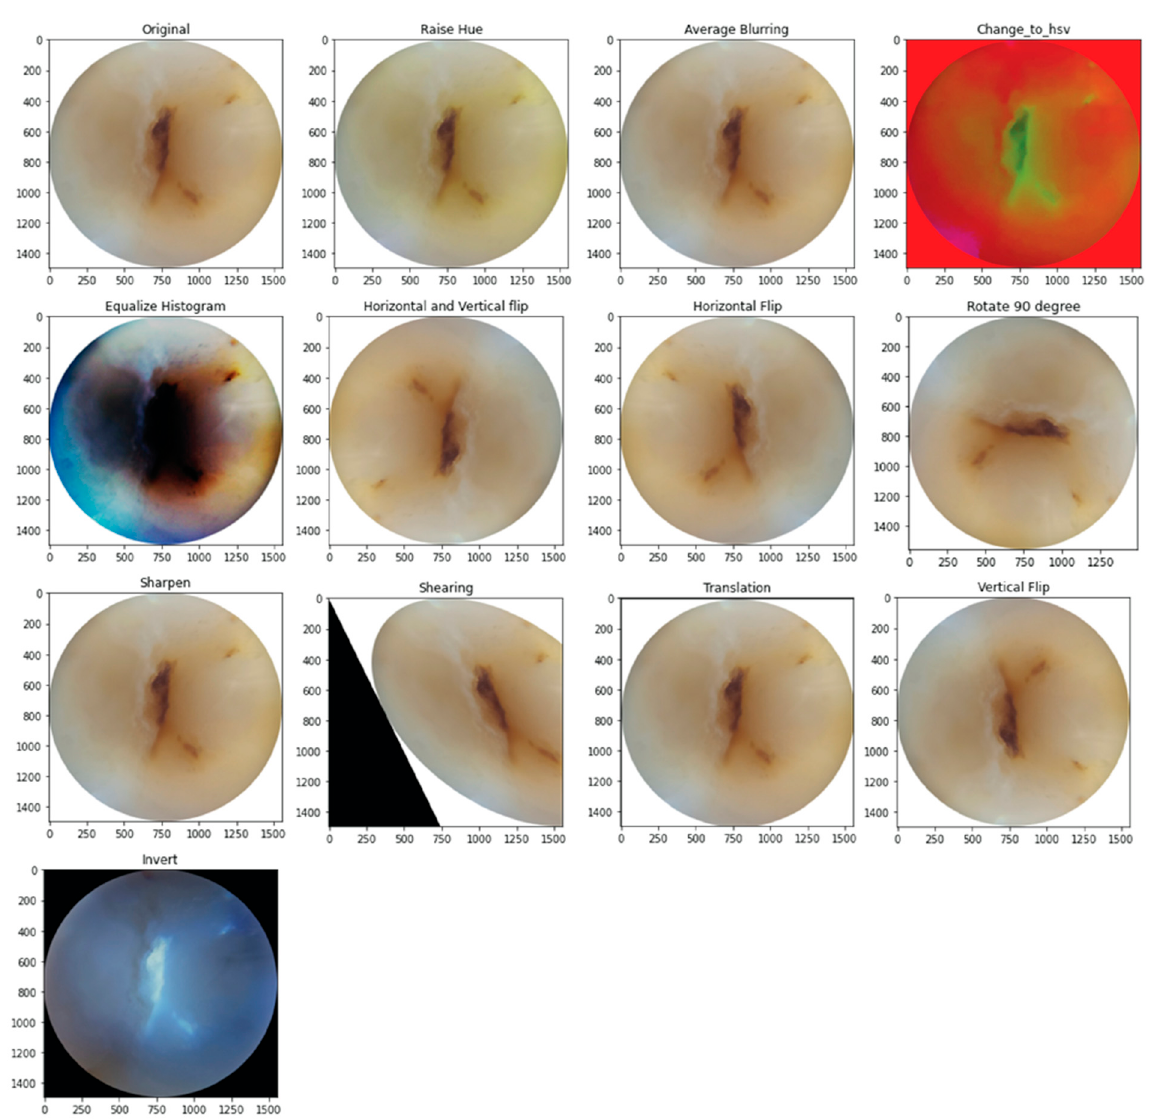
Figure 1. Examples of image augmentation.